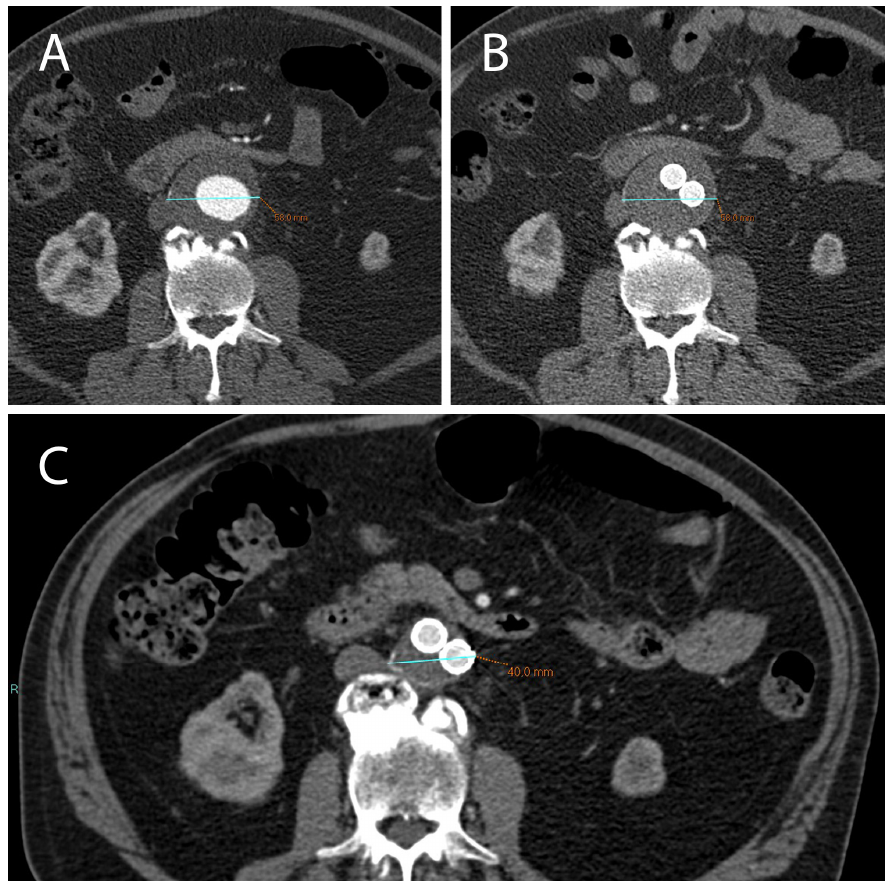
Figure 1. ( A ) CTA axial images show an AAA with a diameter >5.5 cm (in this case 5.8 cm) which can be treated with EVAR. ( B ) After 1 month following EVAR implantation, CTA was used to assess endoleak occurrence; of note, there was no significant reduction in AAA diameter in this short time-range. ( C ) After 12 months following EVAR intervention, a correct aneurysmatic sac exclusion without endoleak led to a significant reduction in AAA diameter (in this case the aneurysm diameter went from 5.8 cm to 4 cm).